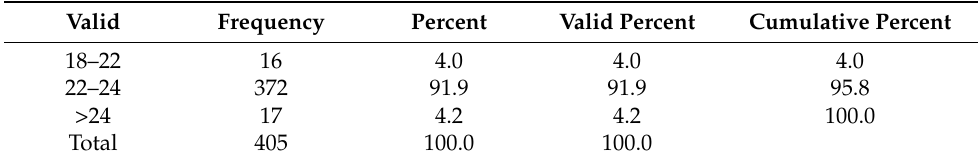
Table A2. Age distribution.